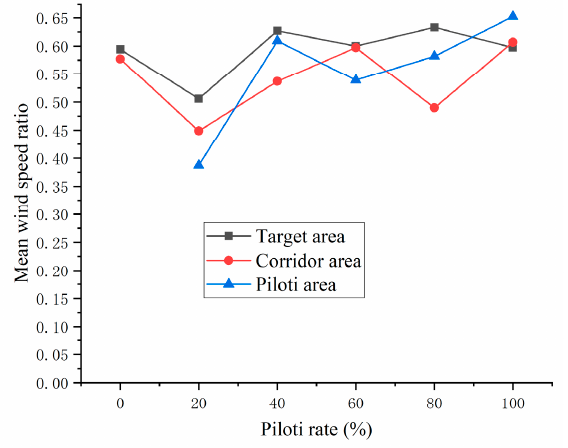
Figure 17. Variation of mean wind speed ratio in the enclosed model.